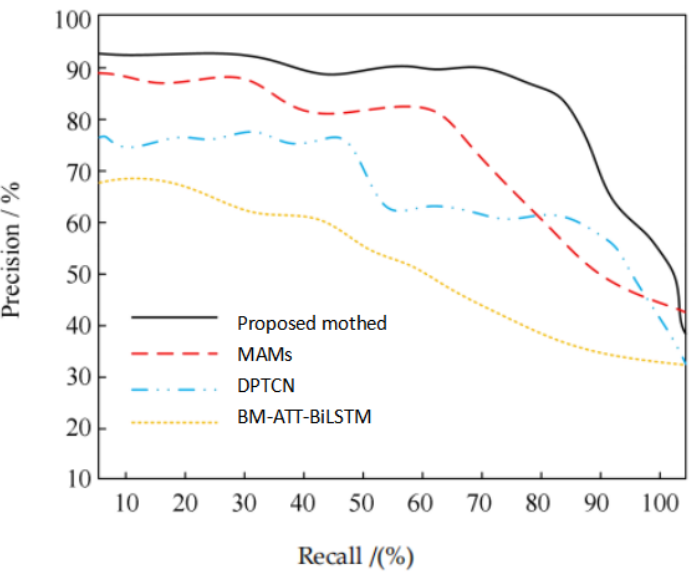
Figure 15. P–R curve of different methods under SNs dataset. Figure 15. P – R curve of different methods under SNs dataset.